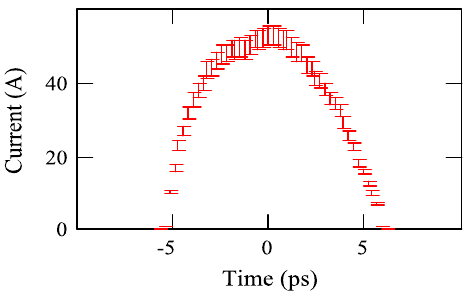
FIG. 5. Beam current as a function of time along the micro- bunch. Error bars represent (cid:2) 1 standard deviation evaluated by combining quadratically the relative local uncertainties on charge and bunch length ( (cid:1) 5% ).